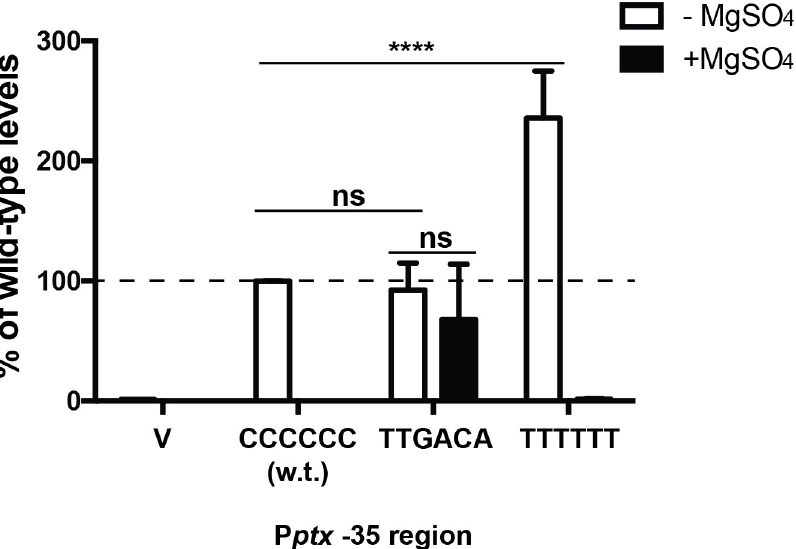
Fig 6. A non-consensus -35 region is required for BvgA-regulated P ptx activity. Luciferase activity of B . pertussis BP536 carrying ectopically integrated plasmids. Values for the empty pSS3967 control (V) and for promoter- lux fusion derivatives harboring the wild type (P ptx ) and -35 substitution derivatives are presented. Strains were grown on BG agar at 37˚C for 2 days and assayed as described in Materials and Methods. Values were normalized to wild-type P ptx and data from at least four assays were used in the calculation of means, standard deviations, as indicated by error bars, and statistical analysis by one-way ANOVA. Outcomes of the latter analysis are presented using the symbols: ns, P > 0.05; � , P � 0.05; ���� , P �